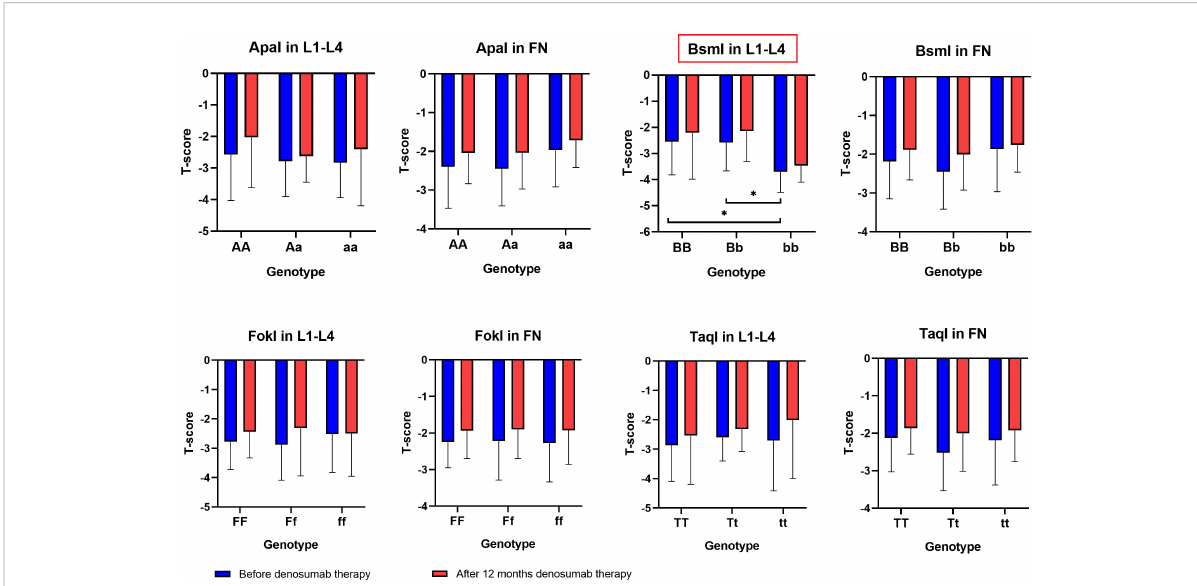
FIGURE 3 T-score results in the femoral neck (FN) and L1 – L4 area for ApaI , BsmI , FokI , and TaqI genotypes of the VDR gene in a studied group before and after one year of denosumab therapy (*P <